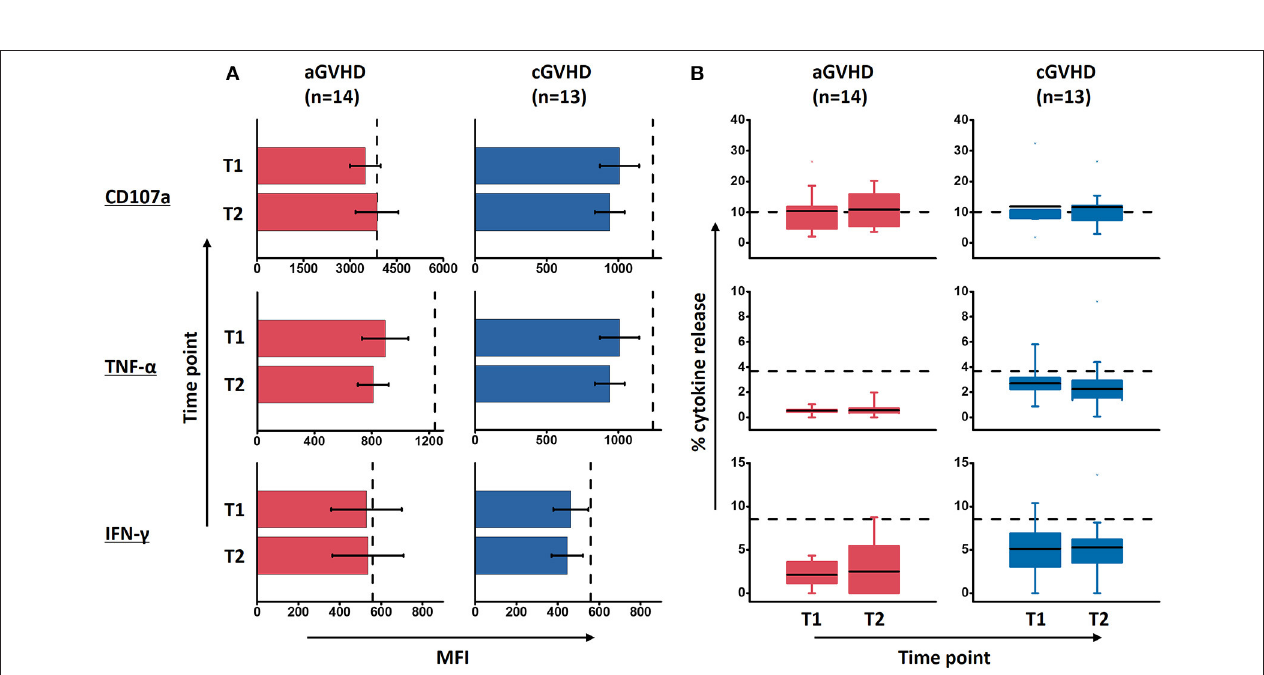
FIGURE 6 | Effect of ECP on CD56 dim CD57 + NKG2C + NK cells. (A) shows the analysis strategy of CD56 dim CD57 + NKG2C + NK cells. This specialized anti-viral/relapse subset could be preserved after long-term ECP treatment in both aGVHD (B) and cGVHD (C) patients.